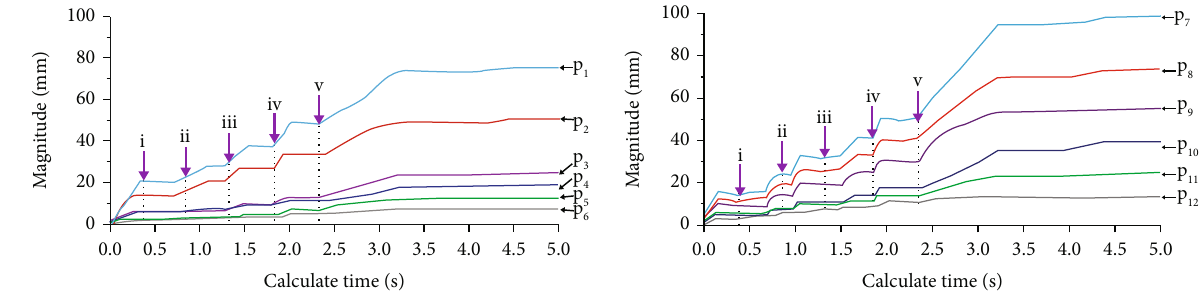
Figure 10: Variation law of total displacement at each measuring point with the calculation time